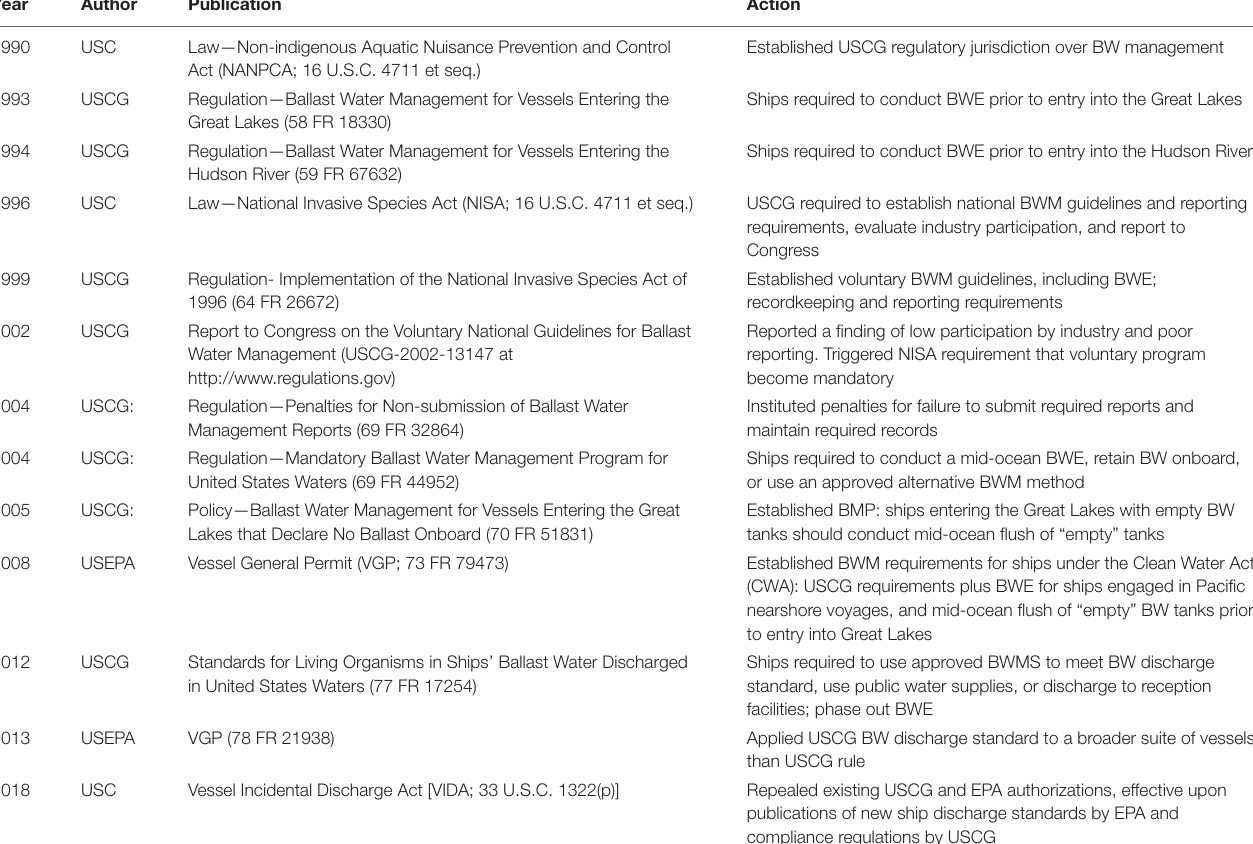
TABLE 1 | Timeline of significant legislation and regulation in the United States regarding ballast water